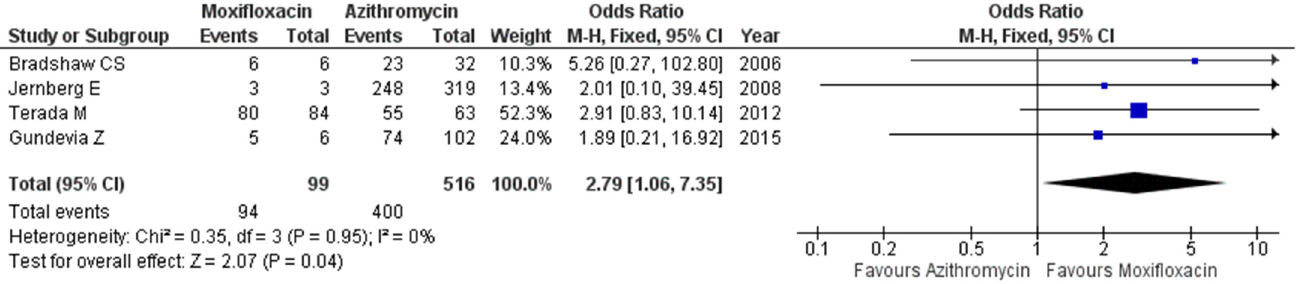
Figure 2. Forest plot presenting odds ratios for microbiologic cure comparing azithromycin and moxifloxacin in patients with M. genitalium infection.